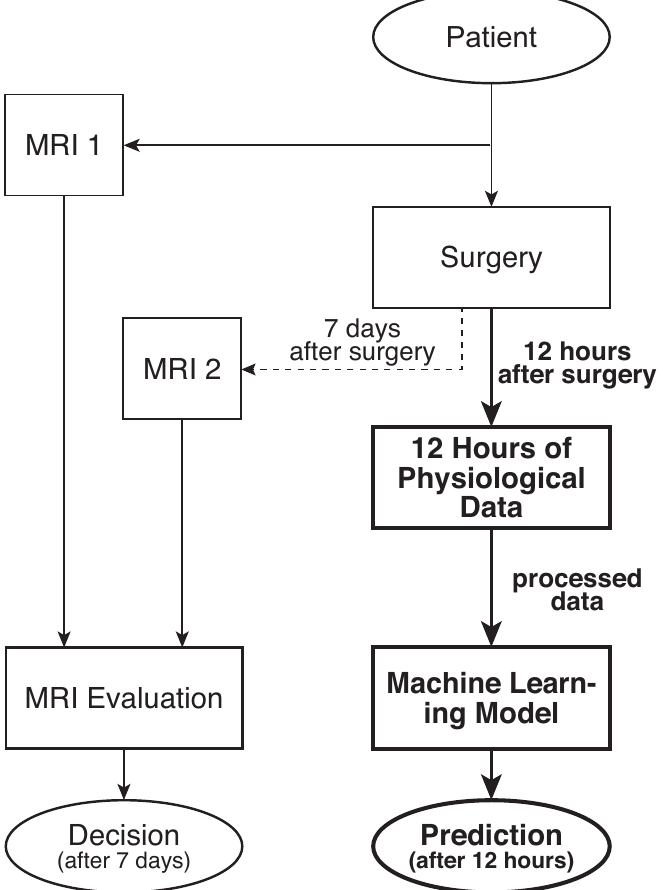
Figure 1. Current decision method after 7 days and proposed predictive method (bold) after 12